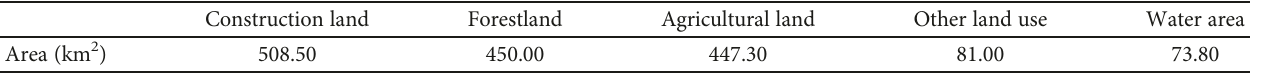
Table 1: Forecasted area of land use in 2020 based on the logistical model.